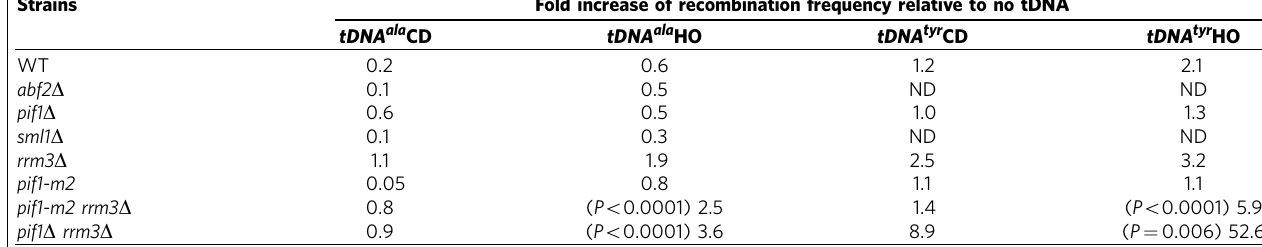
ND, not determined.